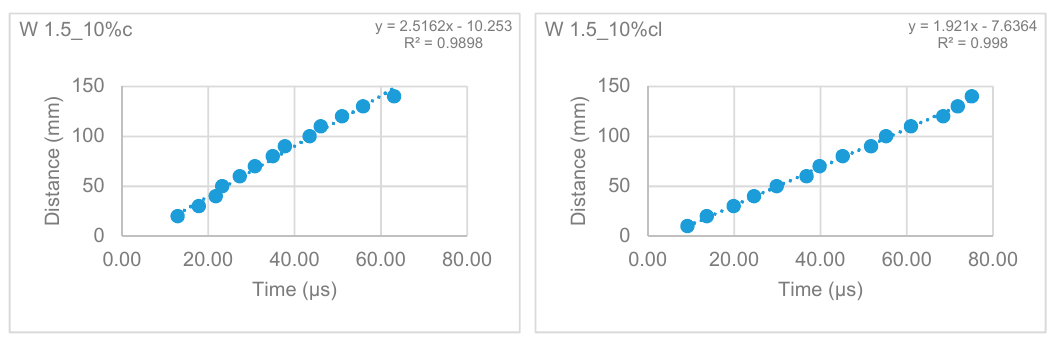
Figure 7. Ultra-sound pulse velocity of the reference mortars. Materials 2017 , 10 , x FOR PEER REVIEW